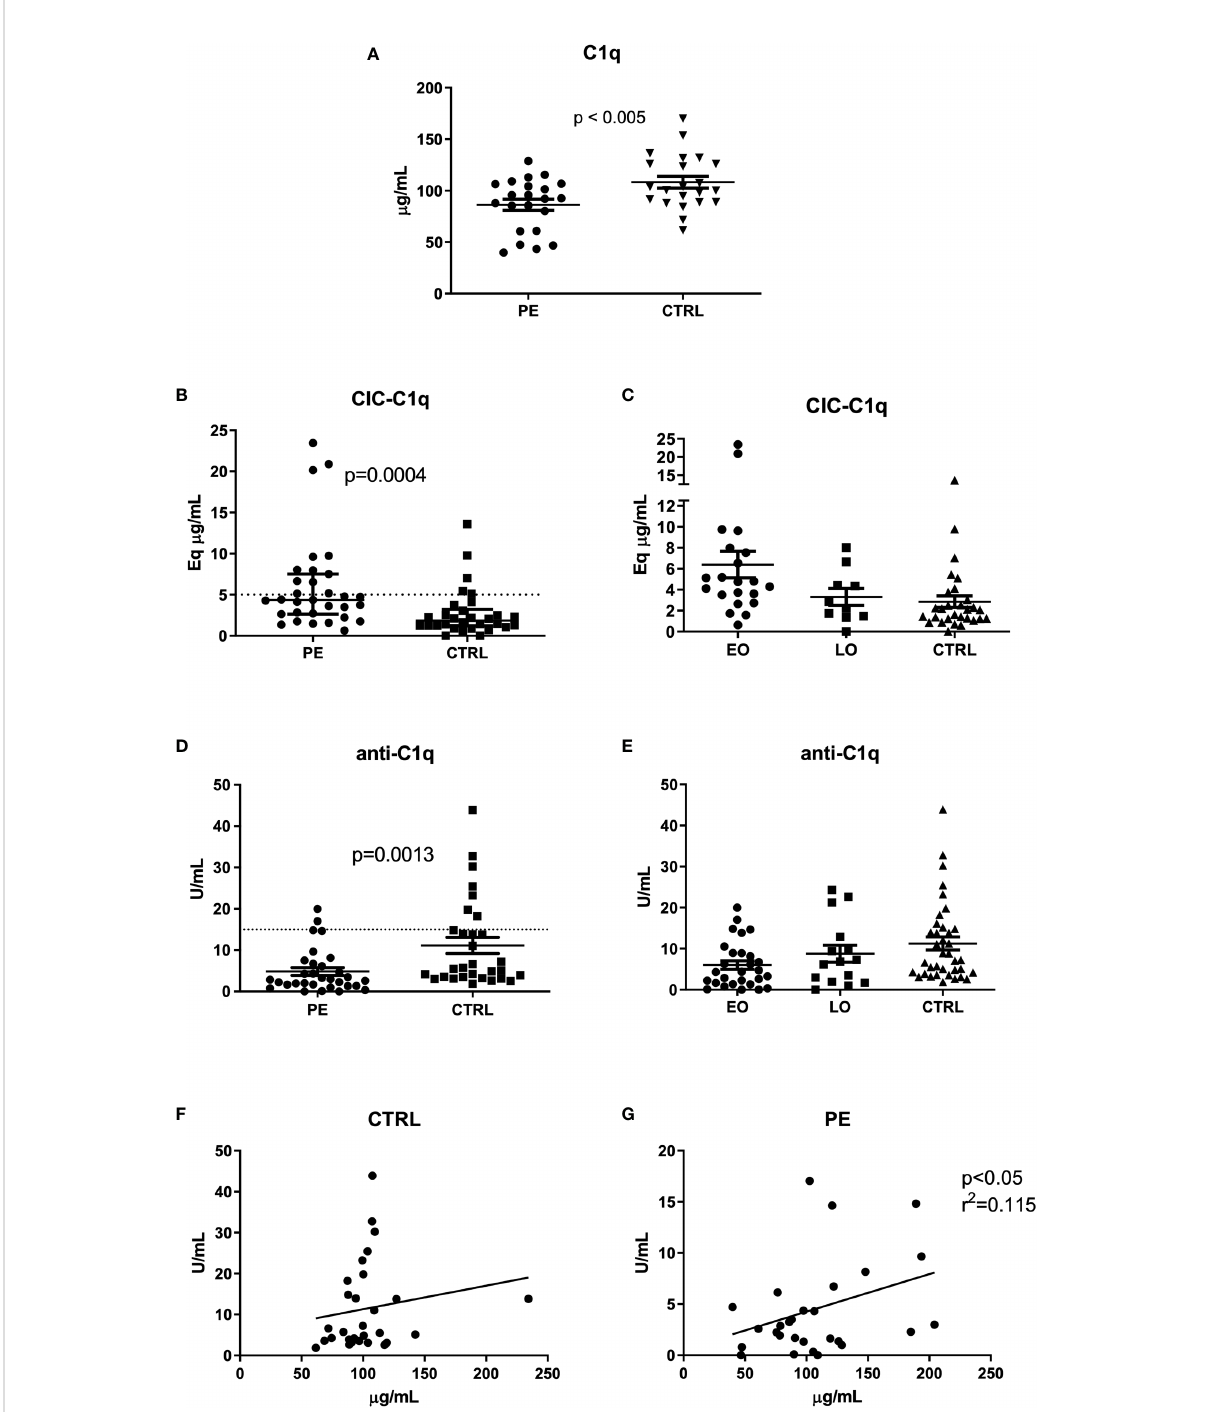
FIGURE 1 C1q, CIC-C1q and anti-C1q levels at the onset of PE. Measurement of C1q (A) , CIC-C1q (B, C) and anti-C1q levels (D, E) in preeclamptic patients (PE) and healthy pregnant women (CTRL). The PE cohort is further divided into Early-Onset (EO) PE (<34 weeks) and Late-Onset (LO) PE (>34 weeks) patients (C, E) . C1q and anti-C1q levels were signi fi cantly lower in PE compared to CTRL (p-value calculated using paired T-test, respectively p<0.005 and p=0.0013). Conversely, CIC-C1q levels were signi fi cantly higher in the PE group (p=0.0004). The differences were more marked in EO PE. The results are expressed as scattered plots; the line in the middle of the graph represents the mean ± standard error. Anti-C1q and C1q levels were correlated by calculating the coef fi cient of determination (r 2 ) in CTRL (F) and in PE patients (G)